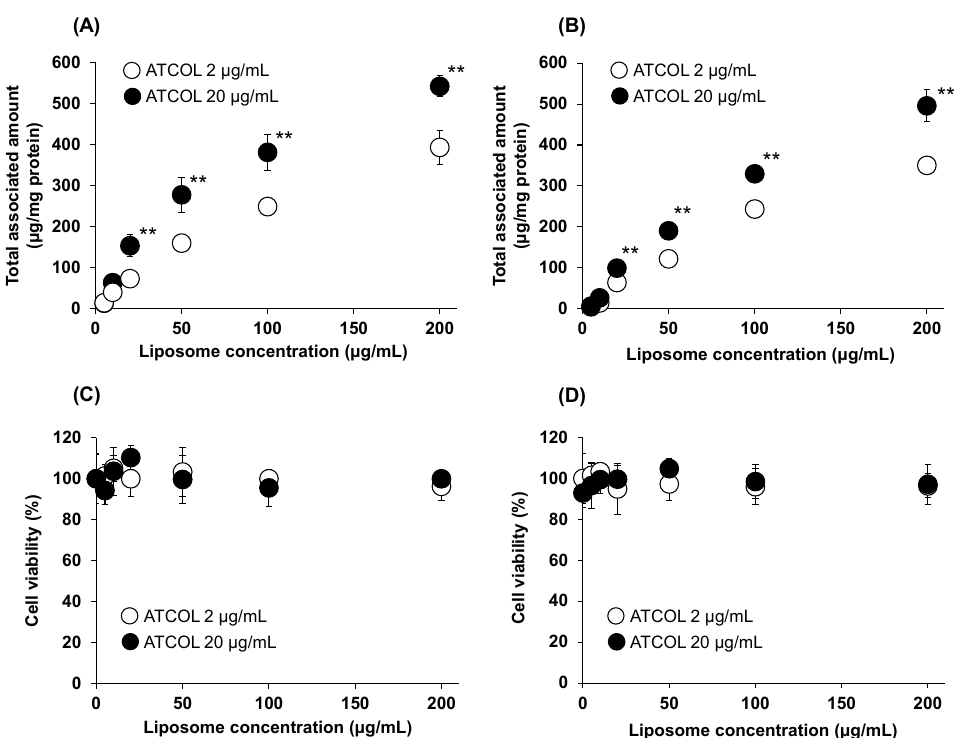
Figure 2. Mag-AL concentration-dependent cellular association and/or uptake of Mag-AL/ATCOL complexes and cell viability in MSCs. Small-sized ( A , C ) or large-sized ( B , D ) Mag-AL/ATCOL com- plexes with 2 µg/mL or 20 µg/mL of ATCOL were added to each well and incubated for 30 min at 37 °C in the presence or absence of a magnetic field. The associated amount of Mag-AL ( A , B ) and cell viability ( C , D ) were measured. Each value represents the mean ± SD ( n = 4). ** p < 0.01, compared with 2 µg/mL of